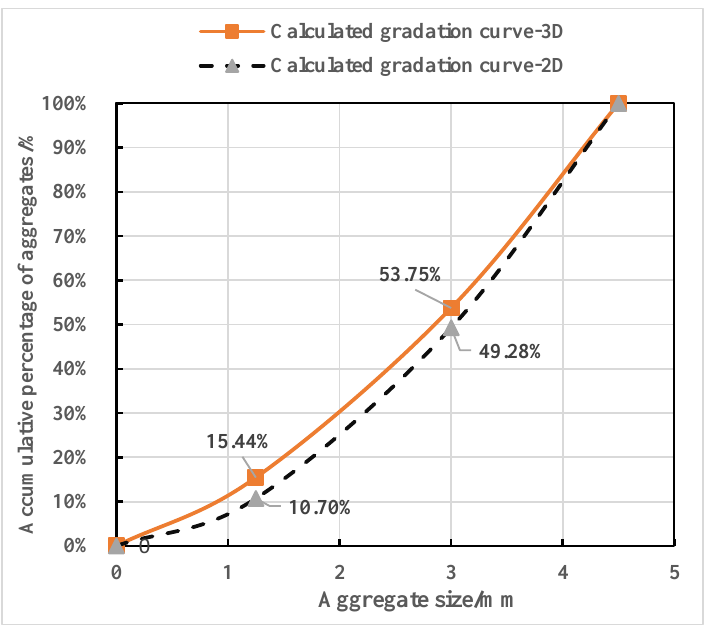
Figure 4. 3D and 2D gradation curves of sand and its three size ranges.